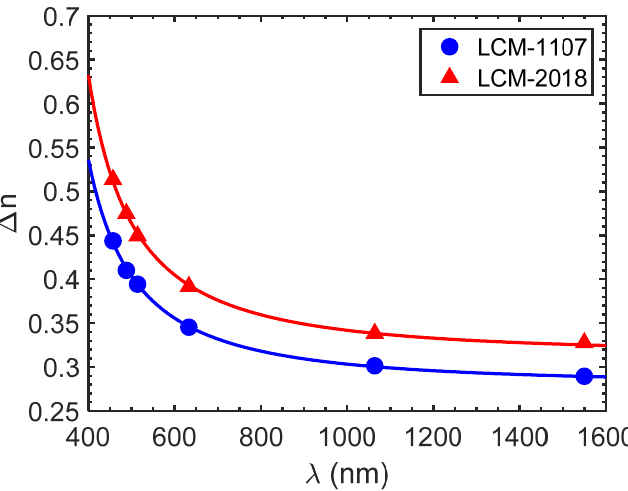
Figure 4. Wavelength-dependent birefringence of LCM-1107 and LCM-2018 at 40 °C and 1 kHz. Dots and triangles are measured data and solid lines are fitting curves with Equation (2).